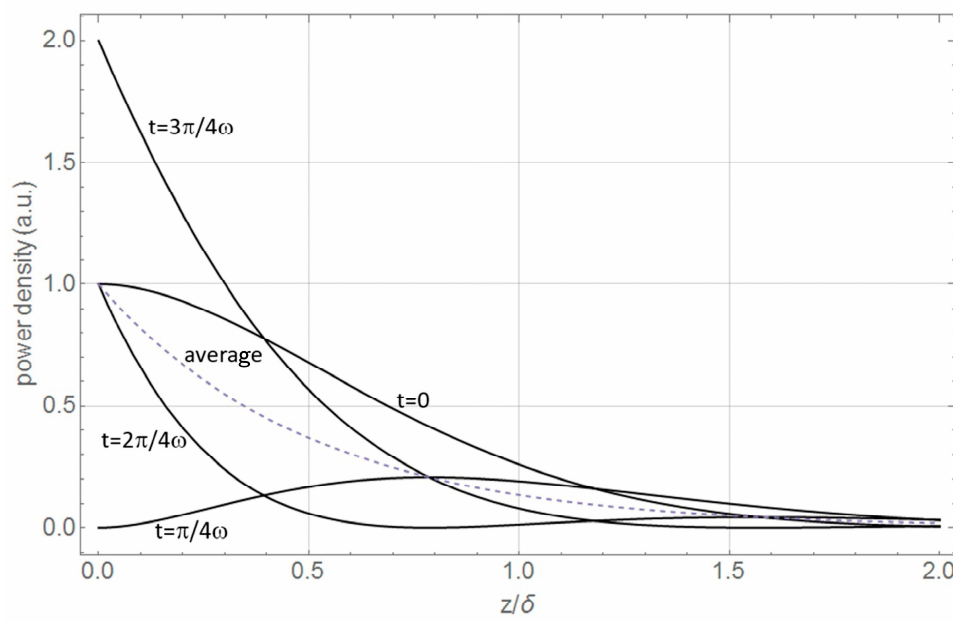
Figure 1. Power density profiles q ( z , t ) in the conducting material for selected times t . The dashed line represents the time average.